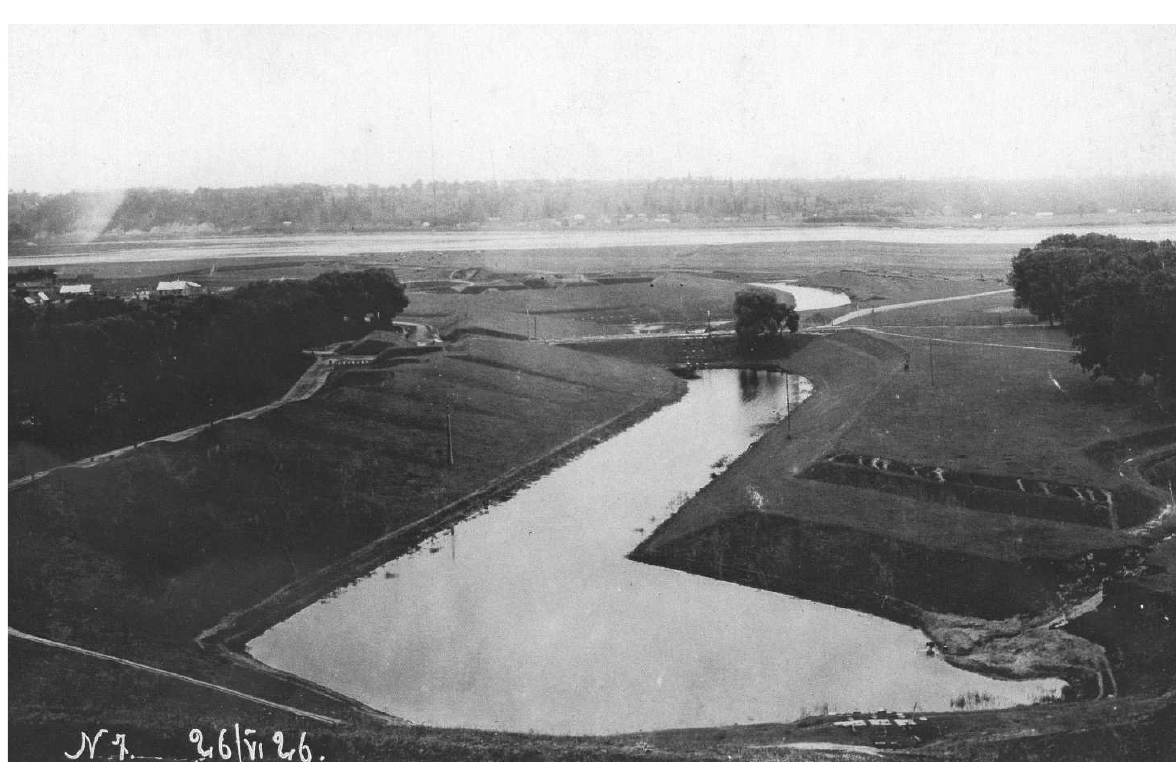
Fig 5. Lower part of Linkuva fortifications: pond and canal near the Neris river (Photo by A. Šulcas,